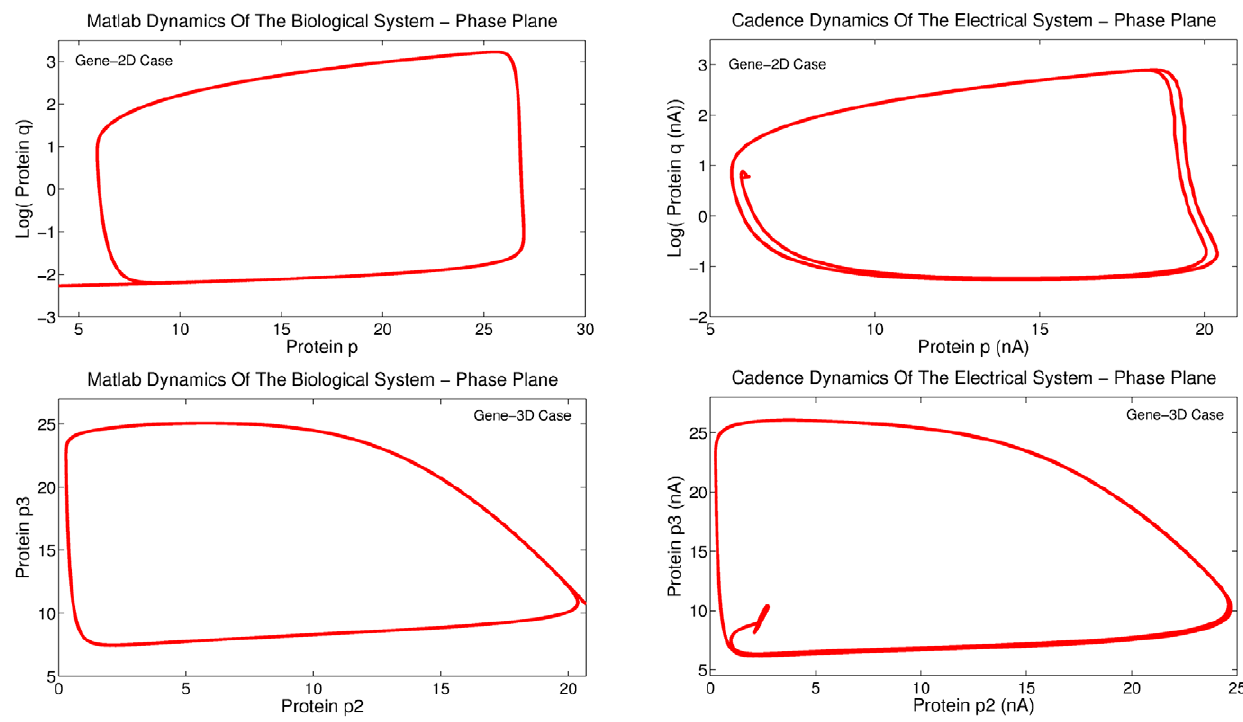
Figure 16. Comparison of phase plane analysis results generated by MATLAB (cid:2) and Cadence simulations for the gene-protein regulatory circuits.